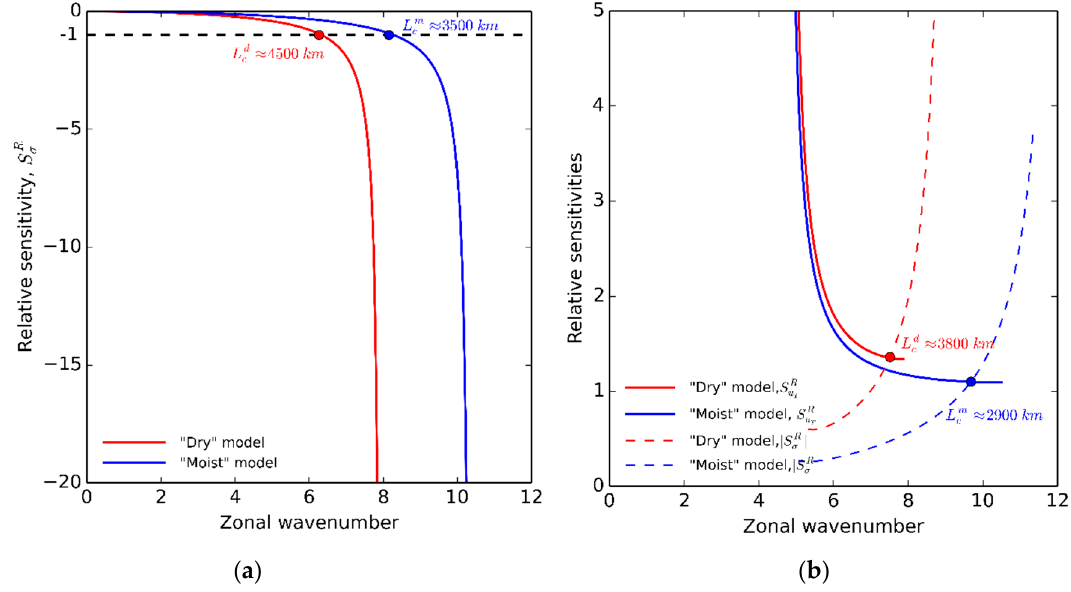
Figure 4. Relative sensitivity functions versus zonal wavenumbers for the “dry” and “moist” ( a ) f -plane and ( b ) β -plane models.